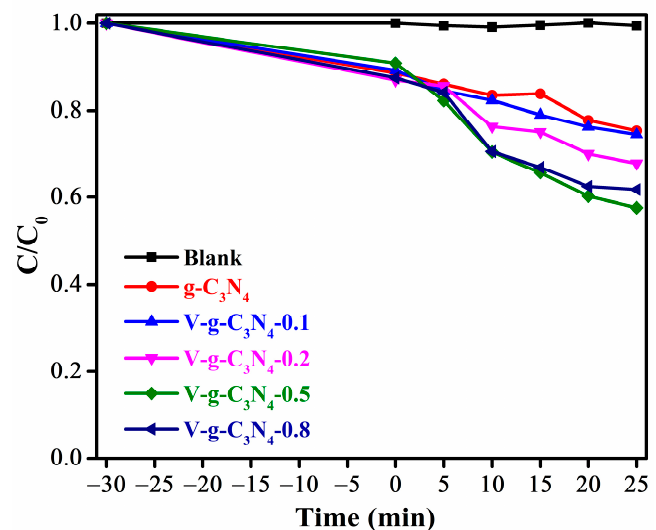
Figure 6. The r emoval efficiency of BPA by the prepared samples. Figure 6. The removal efficiency of BPA by the prepared